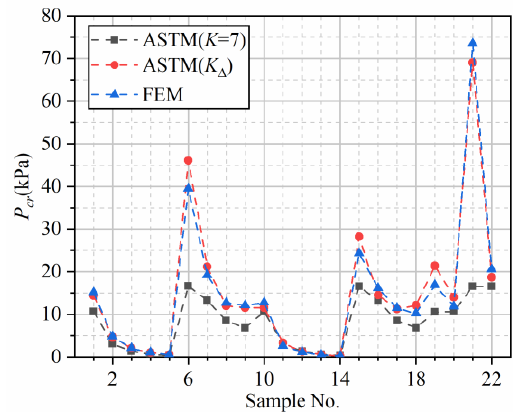
Figure 14. Comparing the critical buckling pressure between the simulation result and result calcu- lated by the prediction